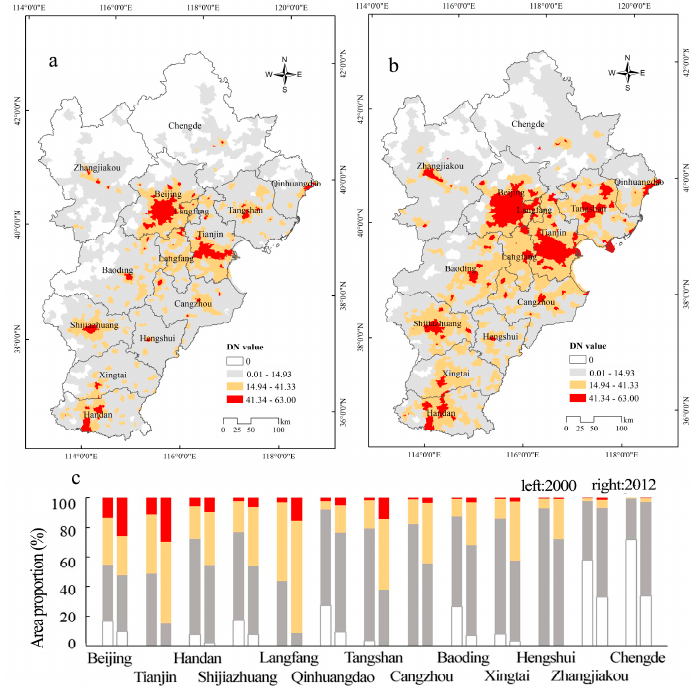
Figure 2. Spatial pattern of nighttime light in Beijing-Tianjin-Hebei urban agglomeration during 2000–2012. ( a ) The DN value of nighttime light image in 2000; ( b ) The DN value of nighttime light image in 2012; ( c ) Area proportion of each level in 2000 and 2012.